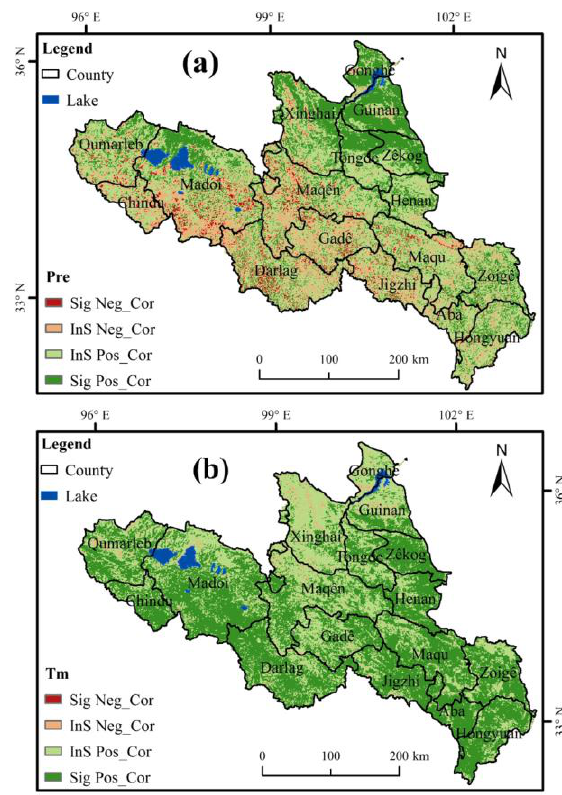
Figure 5. Spatial distribution of the correlation analysis between NDVI and climatic factor: (a) precipitation; (b) temperature.